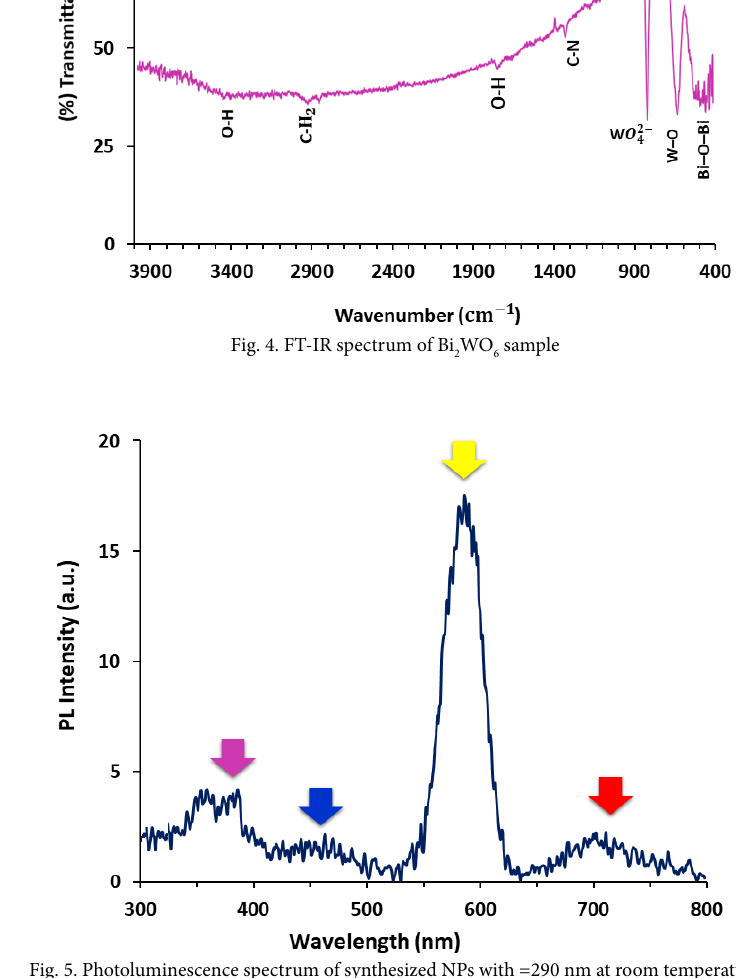
Fig. 5. Photoluminescence spectrum of synthesized NPs with =290 nm at room Figure 5. Photoluminescence spectrum of synthesized NPs with